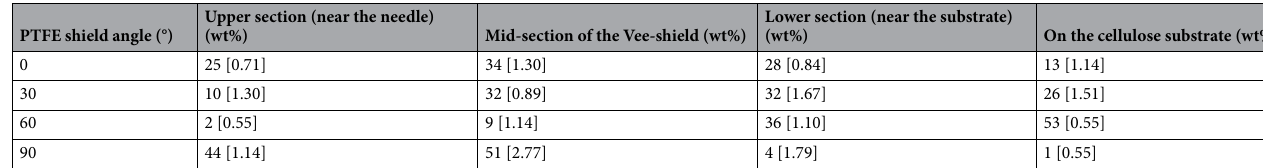
Table 3. Summary of the approximates weights of electro-spun nano-fibres that were deposited on the cellulose substrate and on the Vee-shield over 30